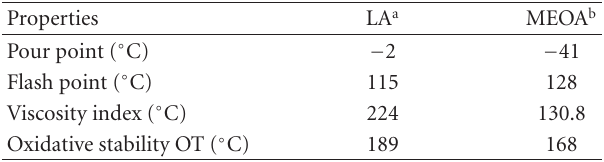
Table 10: Physicochemical properties of LA and MEOA. Properties LA